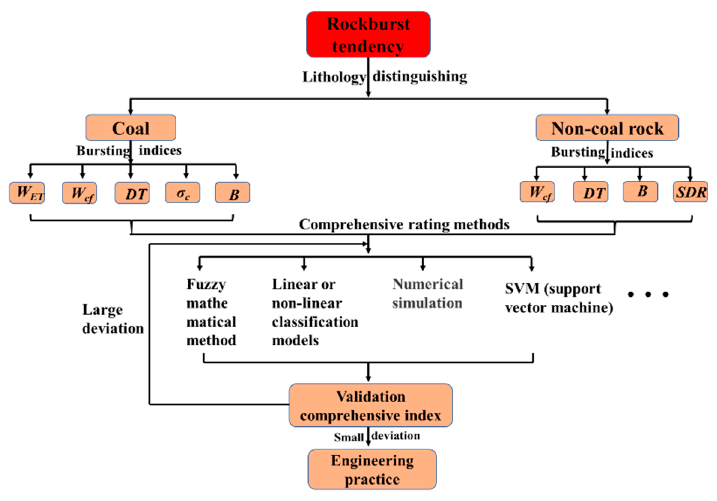
Figure 12. The establishment process of a comprehensive index of coal and non-coal rocks.